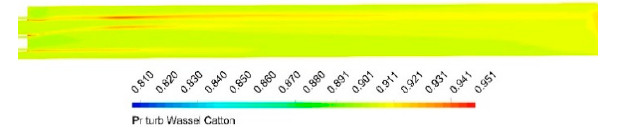
Figure 21. Pr t field in the cylindrical part given by the Kays and Crawford model.